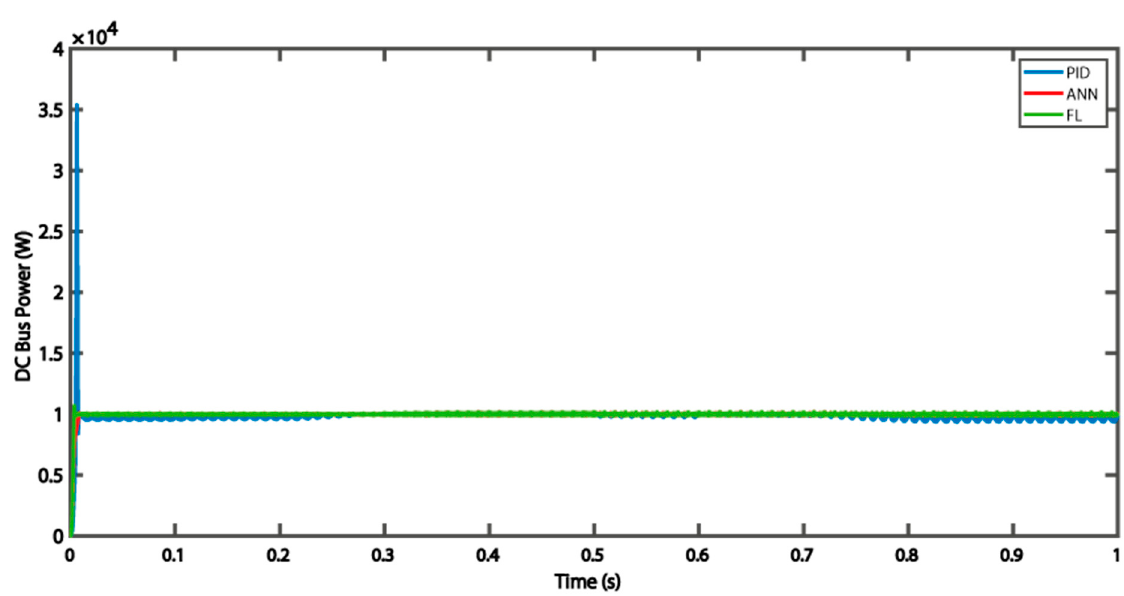
Figure 21. Measured power at the DC Bus (W).